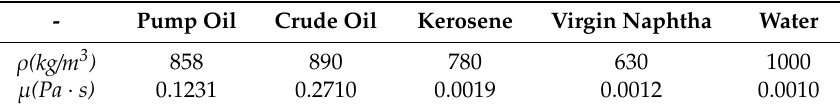
Table 2. Density ( ρ ) and the dynamic viscosity ( µ ) of selected